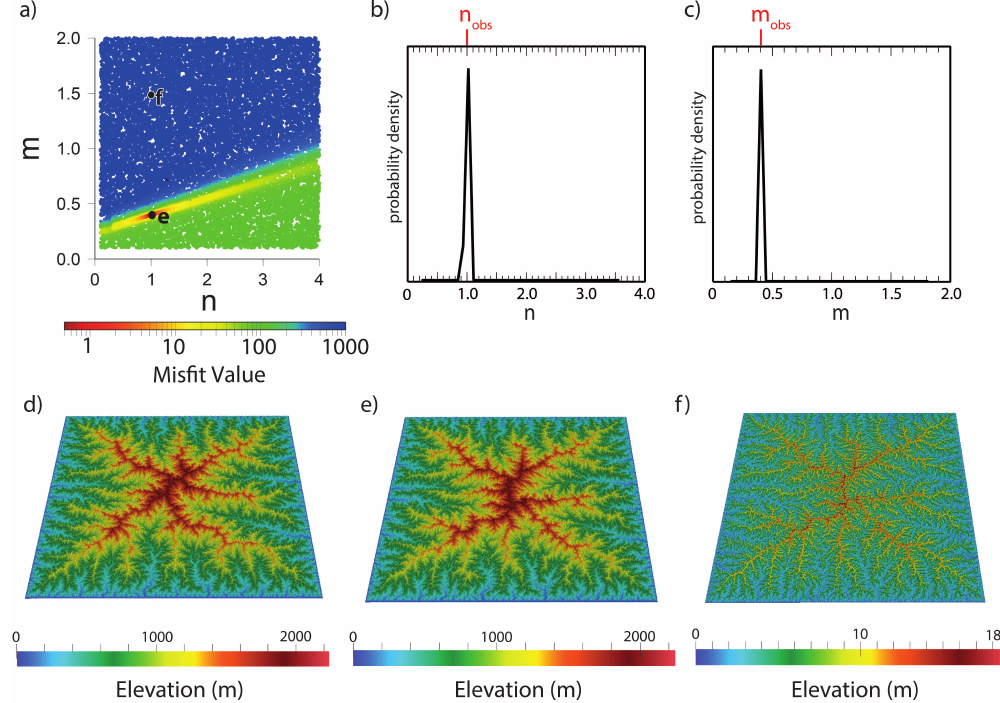
Figure 2. Results from inversion for the free parameters m and n . (a) Scatter plot showing the results from NA sampling stage. (b) , (c) PDFs of the two parameters resulting from the NA appraisal stage . (d) Reference model topography. (e) Topography of the best fit model. (f) Topography of a high misfit value